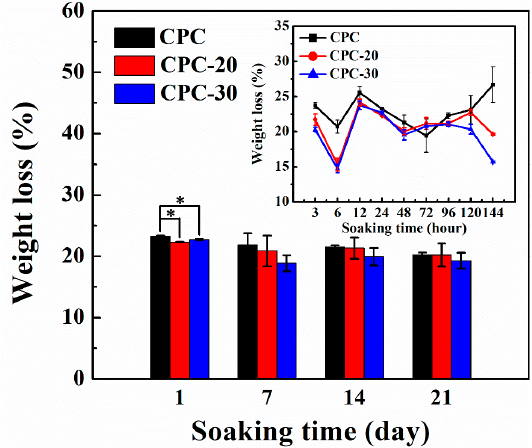
Figure 8. Weight loss% of sample CPC, CPC-20 (20% v/v hydrogel/CPC composite) and CPC-30 (30% v/v hydrogel/CPC composite) during degradation studies (n = 4, * p < 0.05).